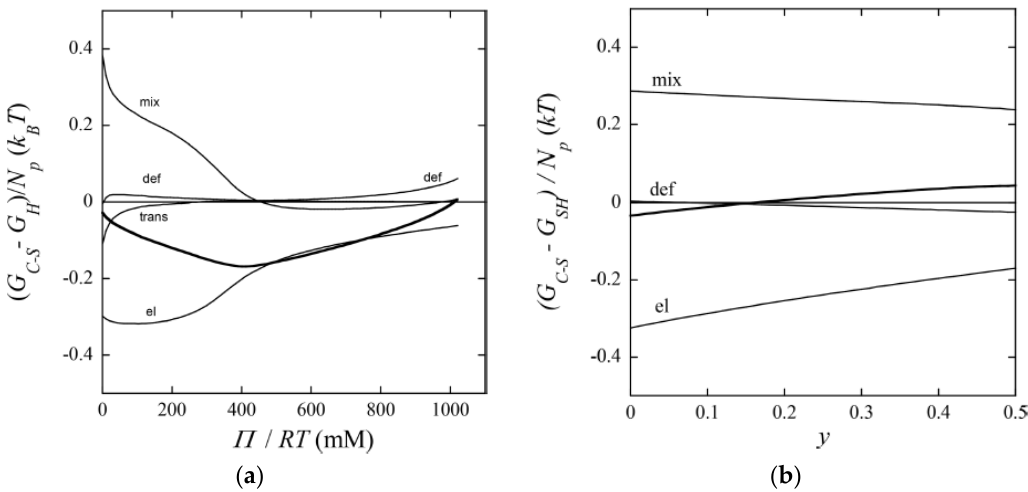
Figure 21. ( a ) Effect of osmotic pressure. Theoretically calculated differences in free energy (per polymer charge) between core−shell and homogeneous states plotted vs. the osmotic pressure for β = 0.5; y = 0; ( b ) effect of micelle charge. Theoretically calculated total difference in free energy (per polymer charge) between core−shell and homogeneous states plotted vs. y for β = 0.5. See legend to Figure 20 for more details. Figure taken from ref. [22]. Reprinted with permission. Copyright 2017 American Chemical Society.